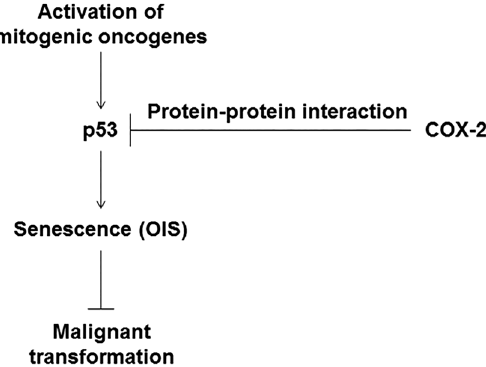
Figure 8. A proposed mechanism for COX-2-mediated malignant